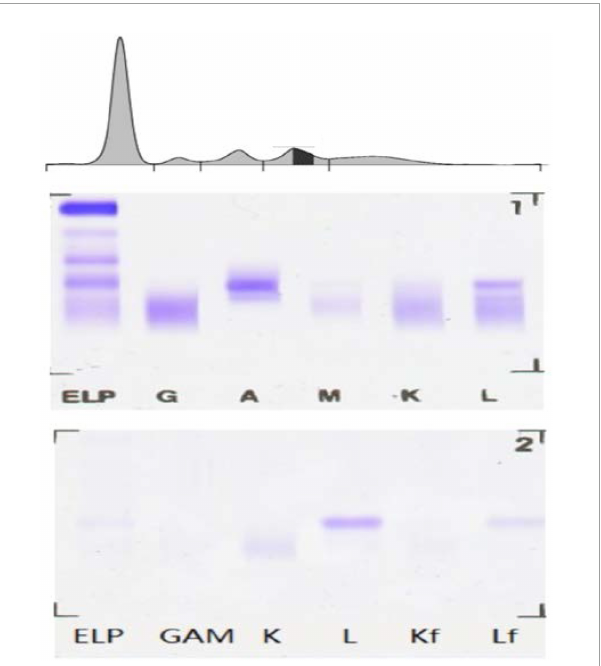
FIGURE1 Serum electrophoresis and immunofixation electrophoresis of the